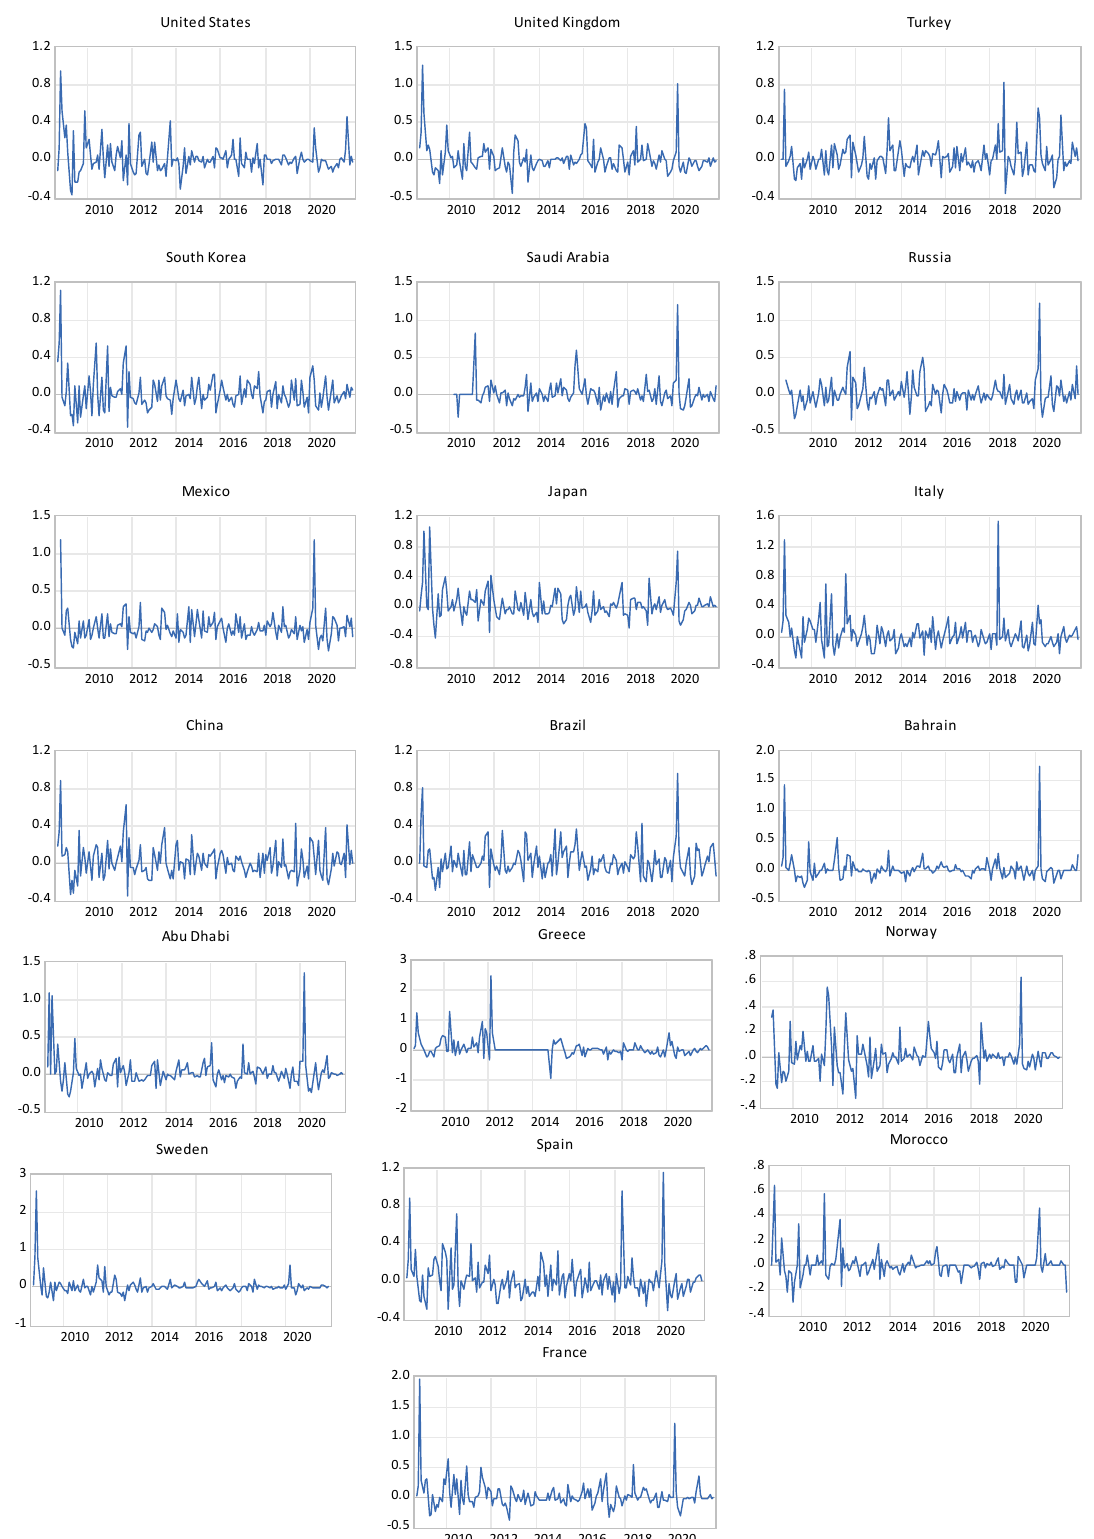
Figure 2. The time ‐ varying dynamics of the SCDSs of nineteen countries. Note: The sample period of the study starts from August 2008 of all SCDS data except for SCDS Mexico (October 2008); SCDS Russia (November 2008); SCDS Norway (January 2009 and SCDS Saudi Arabia (March 2010).